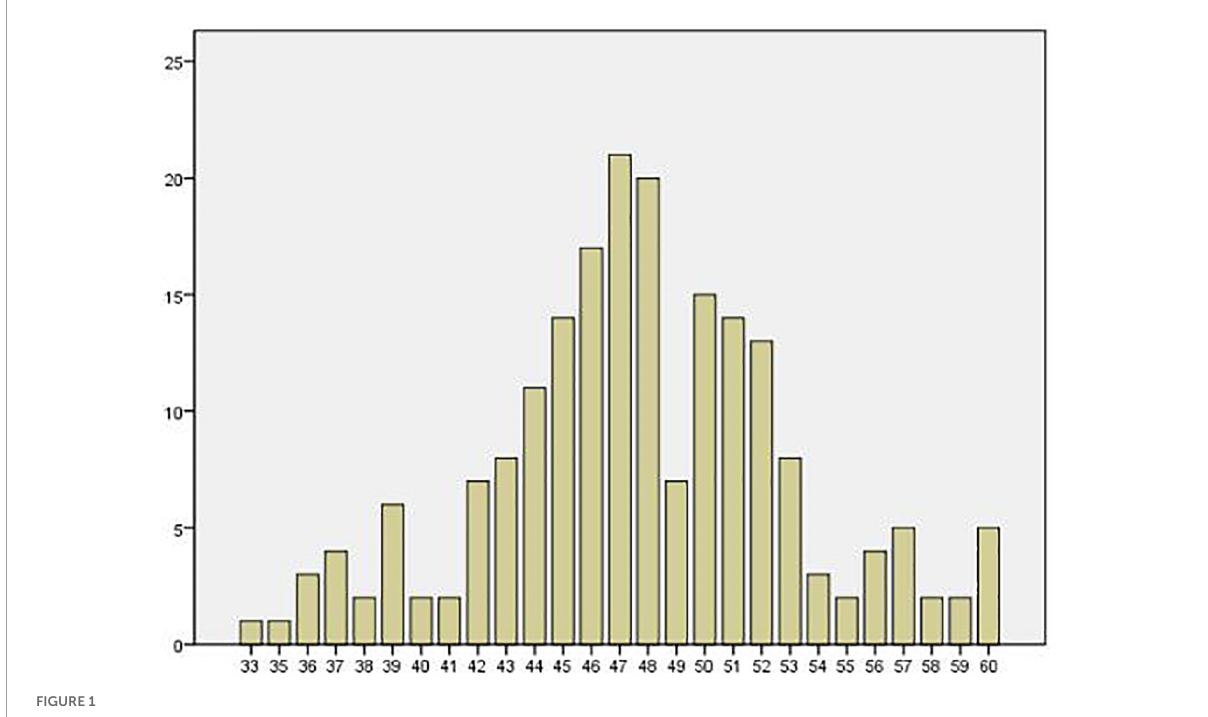
FIGURE1 Bar graph of in-service teacher